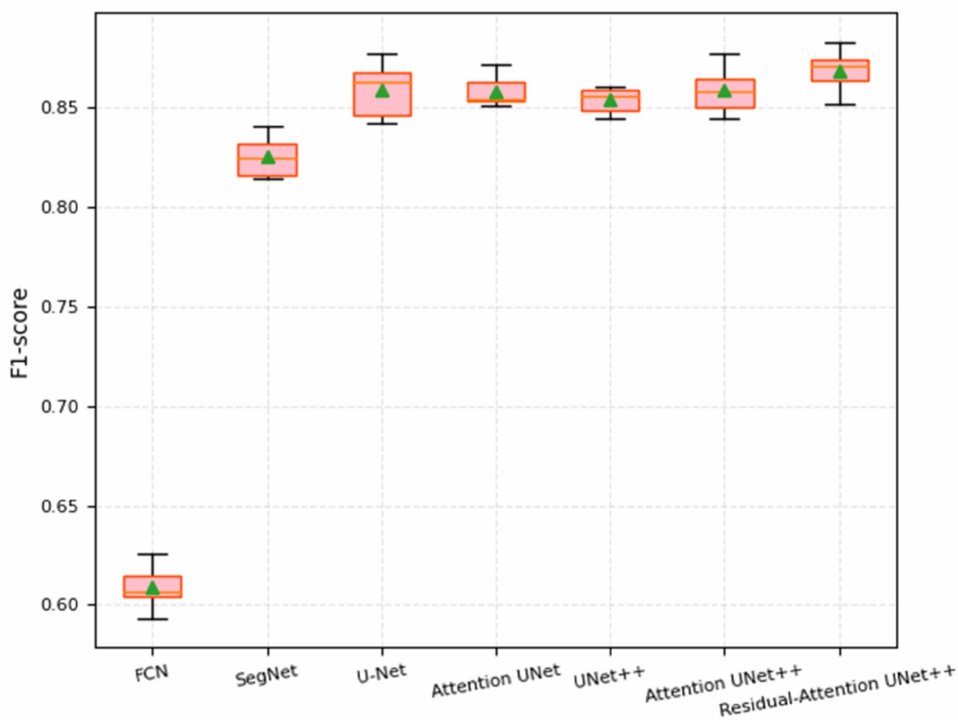
Figure 14. The comparison between Residual-Attention UNet++ and other methods on F1-score after multiple experiments for cell nuclei dataset.